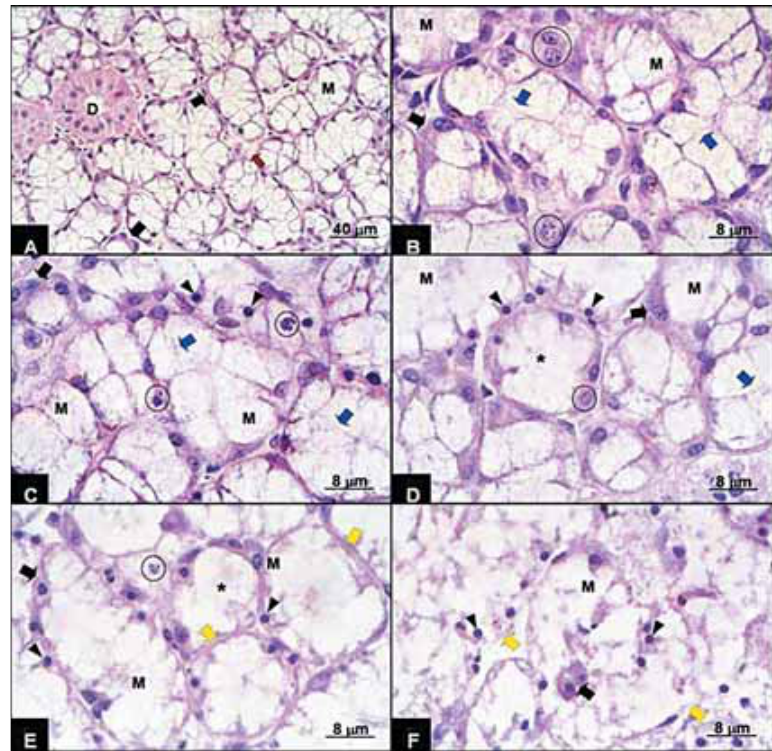
FIGURE 1- Sublingual gland A - 0 h: the glandular structure presents integrity, exhibiting mixed acini with large mucous cells (M) and small half-moon serous cells (full arrow) and intralobular ducts (D) interlaced by stroma (reed arrow). HE; B - 3 and 6 h: mixed acini exhibiting some mucous cells (M) presenting loss of integrity of their external limit (blue arrow) and integral serous cells (full arrow); C - 12 h: mixed acini exhibiting mucous cells (M) presenting loss of integrity of their external limit (blue arrow), karyorrhexis (circle) and pyknosis (arrowhead) and serous cells presenting karyorrhexis (full arrow). HE; D - 12 h: mixed acini exhibiting mucous cells (M) presenting loss of integrity of their external limit (blue arrow) and others showing total disintegration of the external limit (asterisk), karyorrhexis (circle) and pyknosis (arrowhead) and serous (cid:1)(cid:2)(cid:3)(cid:3)(cid:4)(cid:5)(cid:6)(cid:7)(cid:2)(cid:4)(cid:2)(cid:8)(cid:9)(cid:10)(cid:8)(cid:11)(cid:5)(cid:6)(cid:12)(cid:13)(cid:8)(cid:14)(cid:9)(cid:10)(cid:1)(cid:5)(cid:8)(cid:15)(cid:1)(cid:3)(cid:2)(cid:10)(cid:5)(cid:16)(cid:17)(cid:15)(cid:3)(cid:3)(cid:5)(cid:18)(cid:7)(cid:7)(cid:14)(cid:19)(cid:20)(cid:21)(cid:5)(cid:22)(cid:23)(cid:24)(cid:5)(cid:23)(cid:5)(cid:25)(cid:5)(cid:26)(cid:27)(cid:5)(cid:28)(cid:29)(cid:5)(cid:30)(cid:10)(cid:4)(cid:14)(cid:7)(cid:11)(cid:18)(cid:8)(cid:10)(cid:31)(cid:18)(cid:9)(cid:10)(cid:14)(cid:8)(cid:5)(cid:14)(cid:17)(cid:5)(cid:11)(cid:3)(cid:18)(cid:8)!(cid:15)(cid:3)(cid:18)(cid:7)(cid:5)(cid:10)(cid:8)(cid:5)(cid:7)(cid:2)(cid:3)(cid:18)(cid:9)(cid:10)(cid:14)(cid:8)(cid:5)(cid:9)(cid:14)(cid:5)(cid:9)(cid:28)(cid:2)(cid:5)(cid:6)(cid:7)(cid:2)"(cid:10)(cid:14)(cid:15)(cid:4)(cid:5)#(cid:11)(cid:15)(cid:7)(cid:2)$(cid:5) exhibiting mixed acini retaining their limits (yellow arrow), exhibiting mucous cells (M) presenting total and disintegration of the external limit (asterisk), karyorrhexis (circle) and pyknosis (arrowhead) and serous cells presenting pyknotic nuclei (full arrow). An acinus showing a single remaining nucleus was noted. HE; F - 24 h: Complete disorganization of the glandular structure, exhibiting acini presenting external limit rupture (yellow arrow) complete disorganization of the cellular content and integral serous cells dispersed in the amorphous resulting from mucous cell destruction.